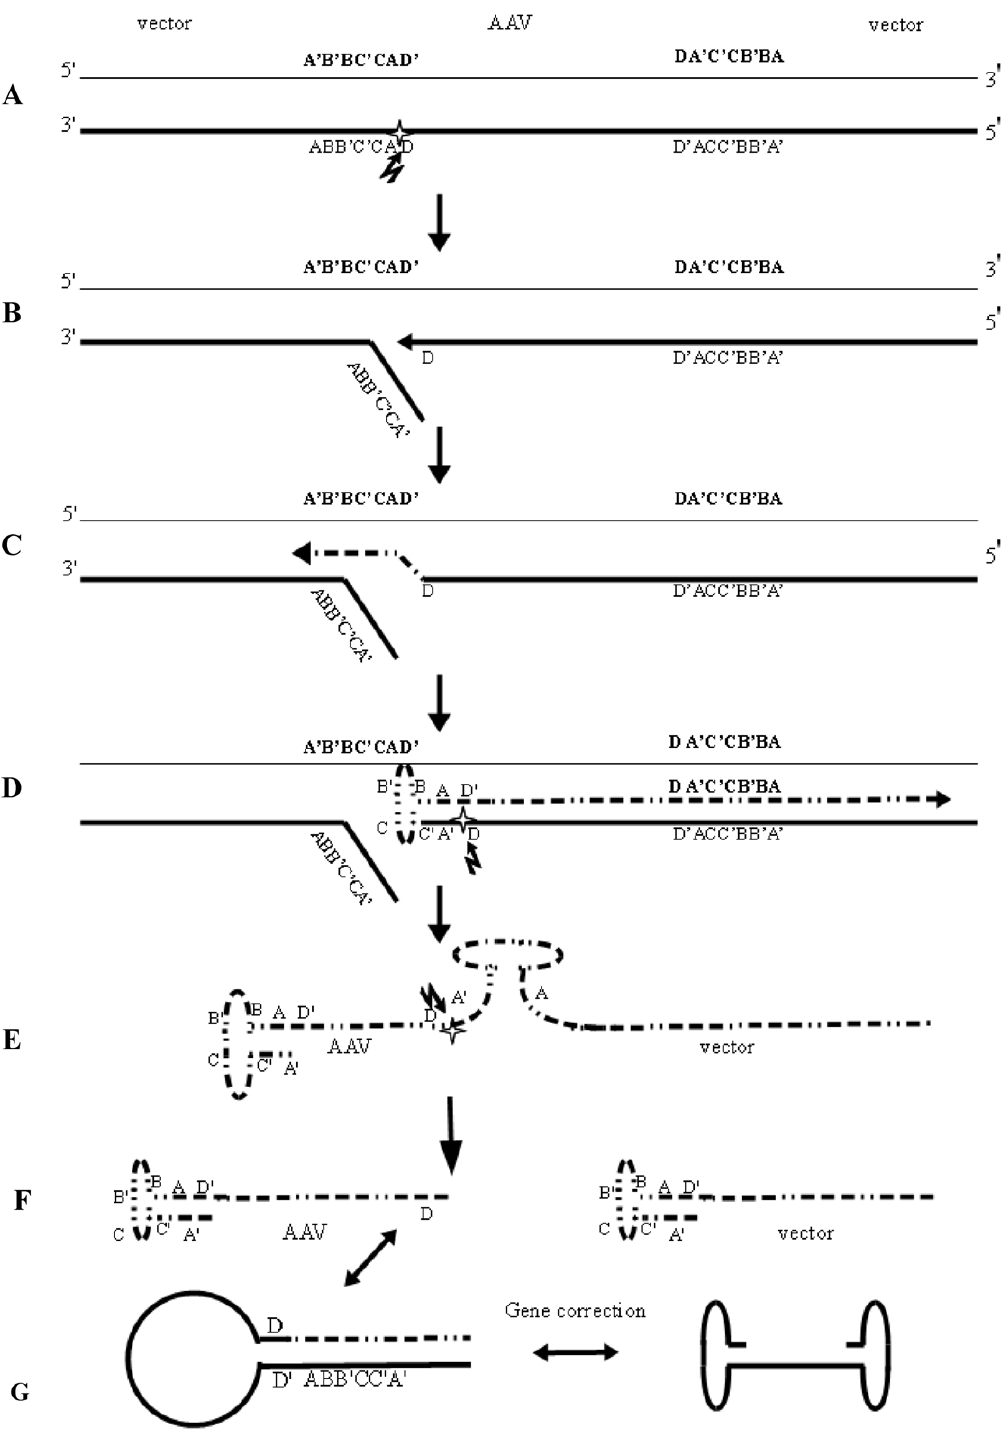
Figure 8. Diagram model showing ssDNA formation from a plasmid containing the AAV genome in yeast. (A) For the sake of clarity, the plasmid carrying ITRs is depicted as linear molecule. Rep nicks at the trs (white star) (B). A replication complex is assembled and replication commences through the ITR towards the vector (C). The new synthesized ITR fold into a hairpin conformation displacing the replication strand. Such displacement determines a template switch so that the originally nicked strand is copied during replication. The replication passes through the other ITR and proceeds into the vector sequence (D). After replication fork has completed a full circle, Rep produces a second nick and the newly synthesized DNA is displaced as ssDNA (E). The new ssDNA is nicked again and two ssDNA containing only one complete ITR are formed (F). The missing ITR is repaired by gene correction mechanism (G).